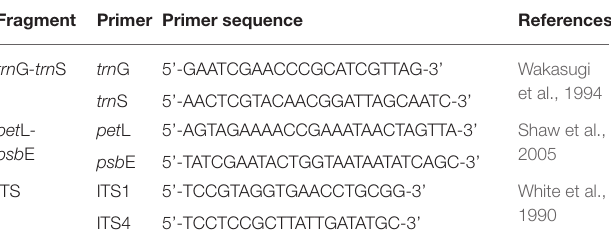
TABLE 2 | Primers for the amplification of selected chloroplast intergeneric spacers and ITS. Fragment Primer Primer